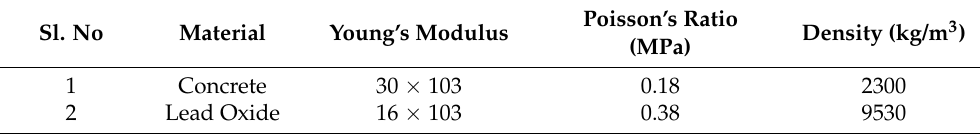
Figure 11. Contact generation. 4.2.4. Mesh Generation Mesh generation was assigned with mapped face meshing to arrive at the near-exact solution. The h-type and p-type methods were used to analyze the results. The process uses a tetrahedron element with 10 nodes of the second-order condition [25]. Figure 12 provides fine mesh conditions with checking other converging conditions. The entire model was solved for 326,070 elements and 856,686 nodes.